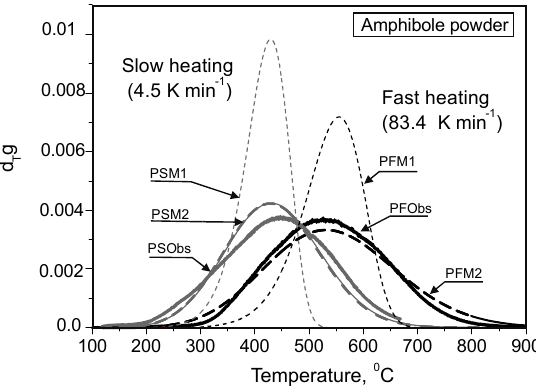
Figure 1. Comparison of the He release patterns (the He flux, K − 1 , versus the temperature, °C), measured in the course of slow (curve Powder Slow Observed, PSObs) and fast (PFObs) incremental heating of the amphibole powder, with the modeling results. 4 He amounts extracted from the powdered samples in the course of slow and fast heating were 4.7 × 10 − 10 and 5.1 × 10 − 10 mol, respectively.